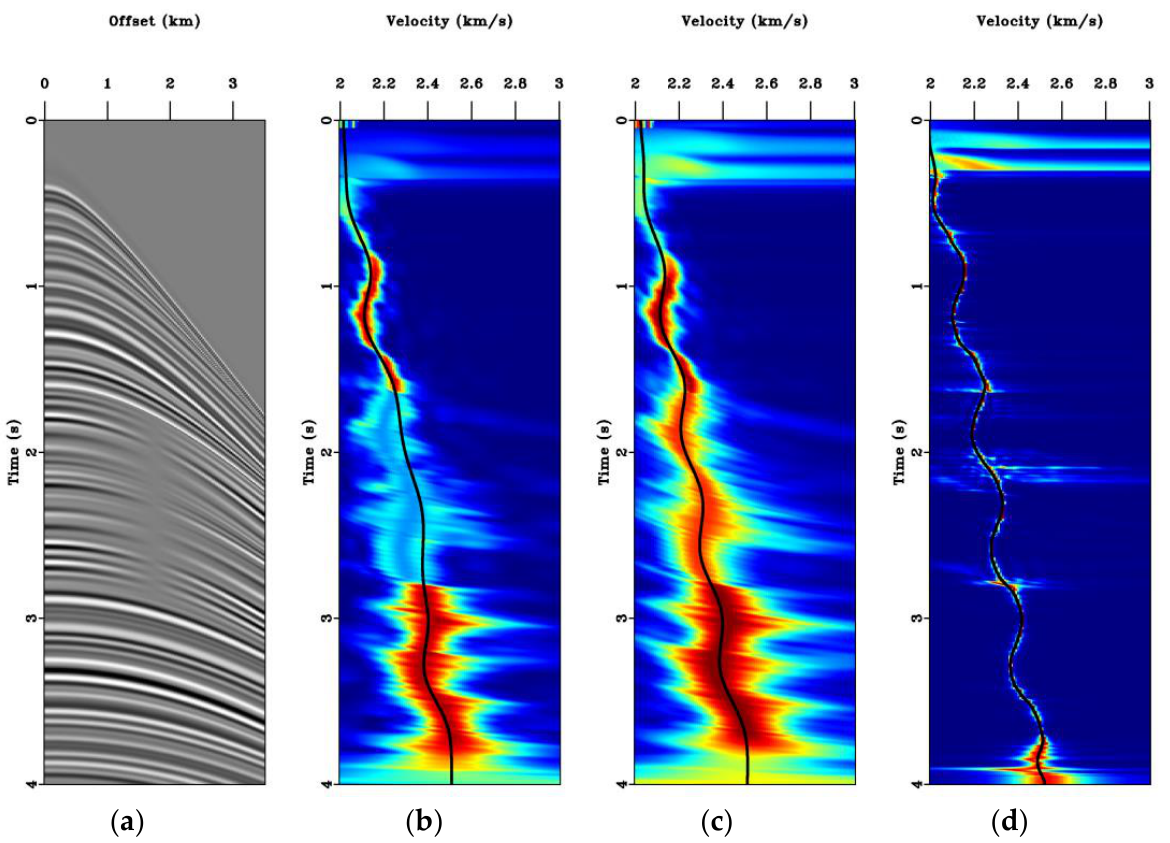
Figure 4. Semblance spectra of the synthetic CMP gather with the class-II AVO anomalies. From left to right: ( a ) uncorrected CMP gather on which all methods of semblances were applied, ( b ) conventional semblance, ( c ) AB semblance, and ( d ) PCA-weighted semblance.